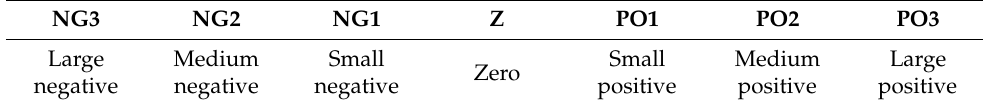
Table 2. Rules of FLC.